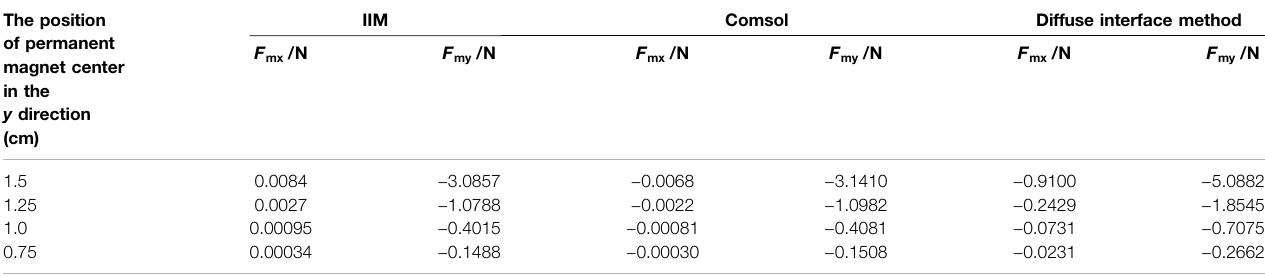
TABLE 1 | The magnetic force on the magnetic conducting cylinder.